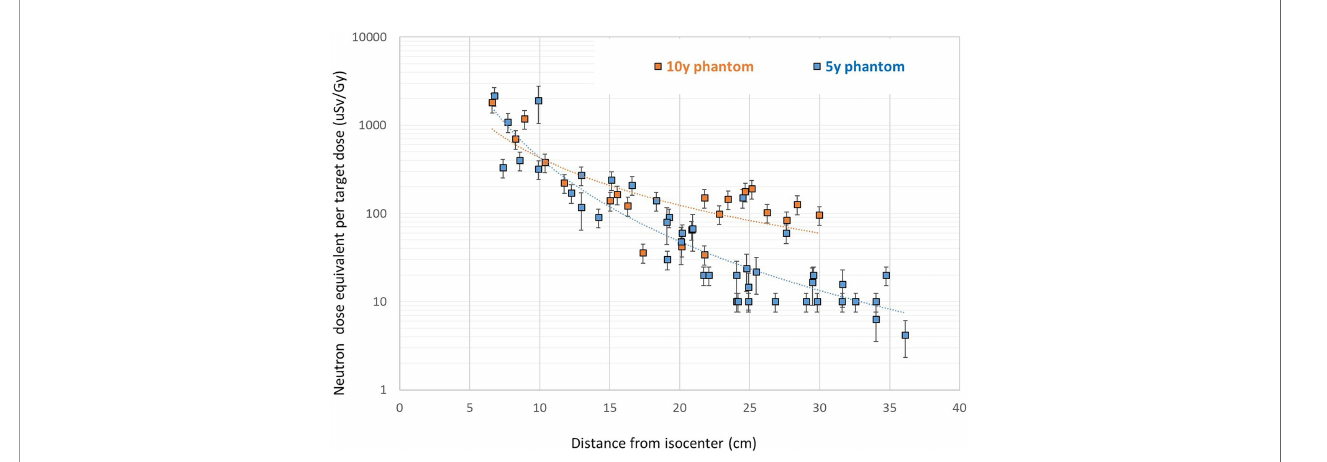
FIGURE 3 | Neutron dose equivalent for the 5- and 10-year-old phantoms measured with PADC detectors. Error bar represents overall uncertainty of the track